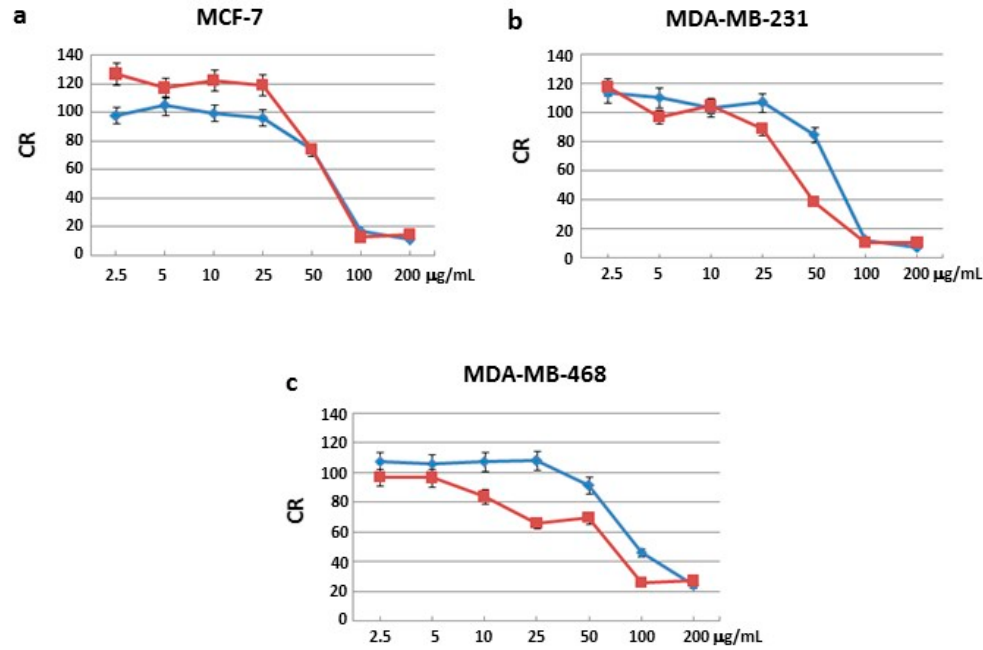
Figure 1. Cell proliferation. Cell viability rate (CR) related to breast cancer cells: ( a ) MCF-7; ( b ) MDA-MB231; and ( c ) MDA-MB468, after treatment with the active sponge Geodia cydonium sub-fraction for 24 (blue line) and 48 (red line) h.